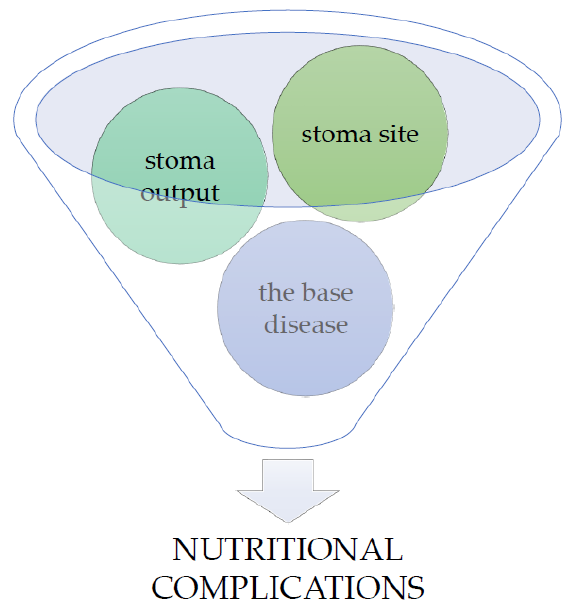
Figure 1. Major situations affecting nutritional complications in stoma